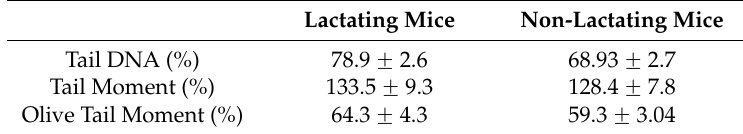
Table 3. DNA damage in lactating and non-lactating C57BL/6NCrl mice. Data are means ˘ SEM. Lactating Mice Non-Lactating Mice